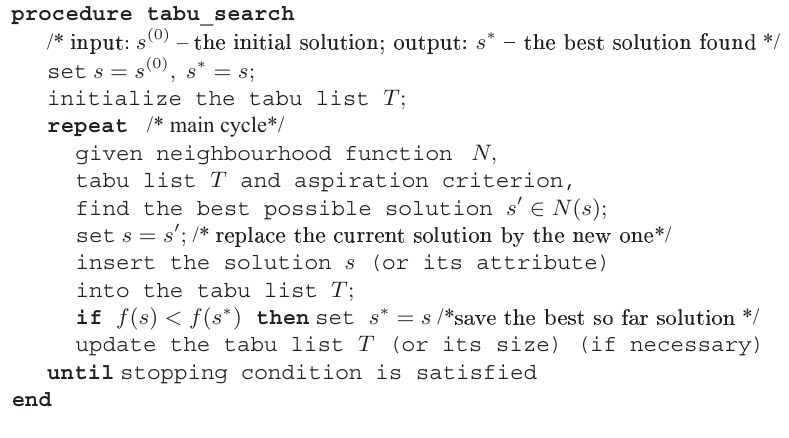
Figure 7. Pseudo-code for the tabu